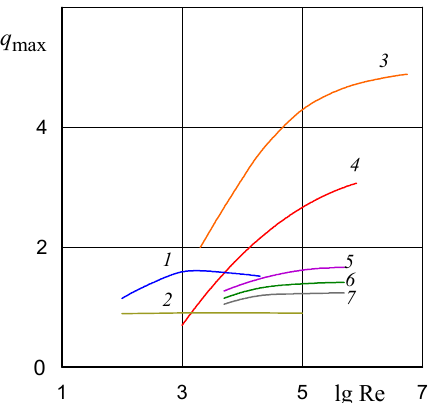
Figure 7. The maximum values of the swirl q , at which the flow is unstable: modes 1–7 at α = 0.4; 0.6; 0.2; 0.3; 0.6; 0.7; 0.8 (curves 1–7). The swirl value, at which the instability is observed for mode 3, reaches q = 4.882 at Re = 5.5 × 10 6 .